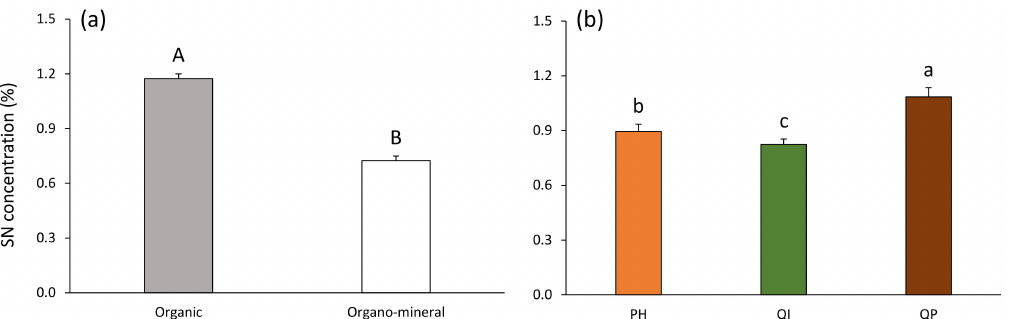
Figure 4. Soil nitrogen concentration according to ( a ) soil layer and ( b ) forest type (Table 2). Data are mean values ± SE and expressed as % per g of DW soil; n = 30. Different capital letters denote significant differences between soil layers with A > B (post hoc Tukey tests results). Different lowercase letters denote significant differences between forest types with a > b > c (post hoc Tukey tests results). SN—soil nitrogen, PH— Pinus halepensis , QI— Quercus ilex , QP— Quercus pubescens